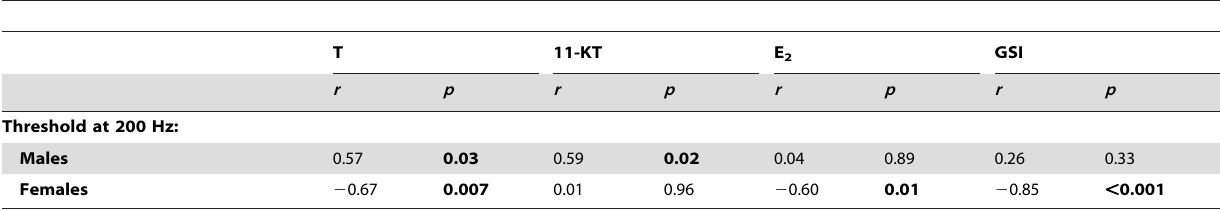
Table 2. Correlations between auditory evoked potential hearing threshold, circulating sex steroid levels, and gonadosomatic index (GSI) in the African cichlid fish Astatotilapia burtoni